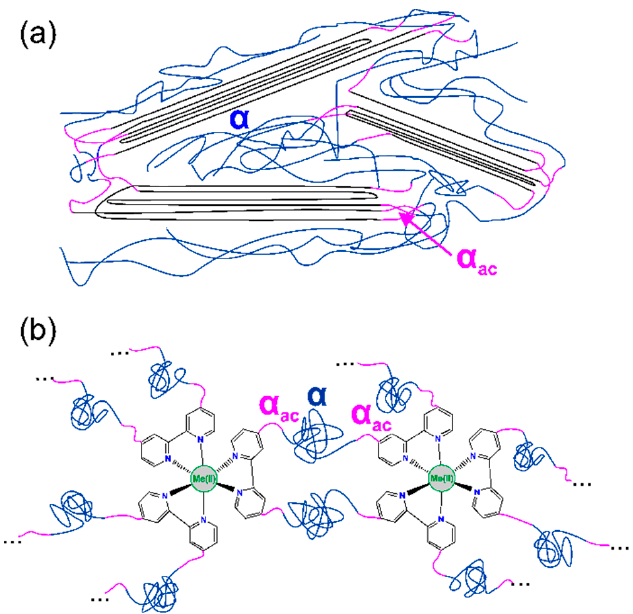
Figure 7. Schematic illustration of origin of α and α ac relaxations in ( a ) non-modified PDMS and ( b ) PDMS cross-linked by metal-ligand coordination (size of the metal-ligand complexes is enlarged to show the structure of the material).